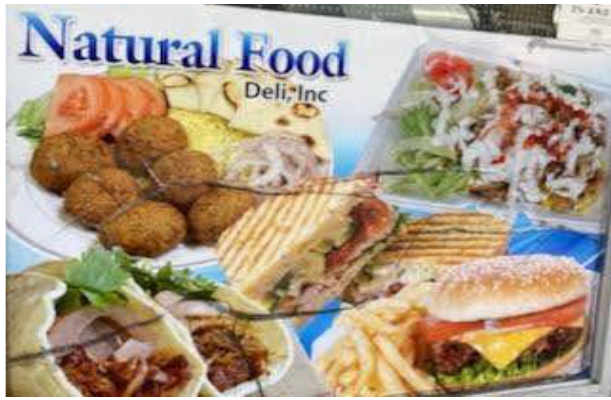
Figure 5. Dependency on pre-cooked meals.